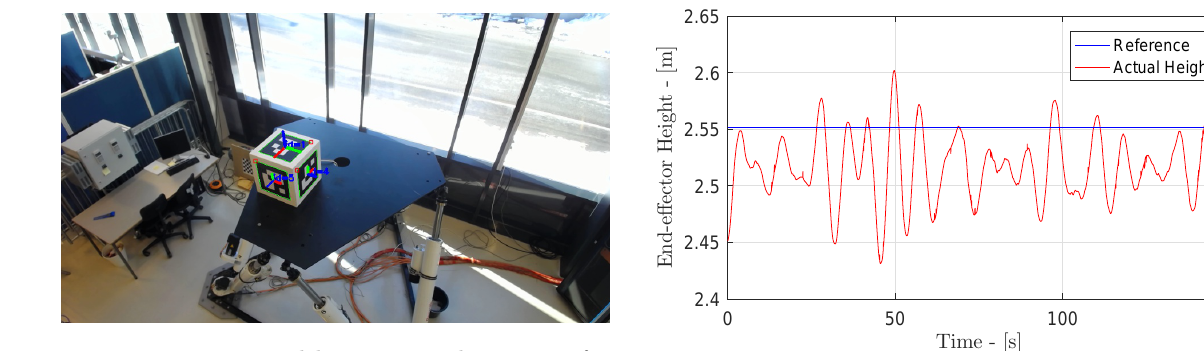
Figure 21: Experimental location number 1 seen from the camera.